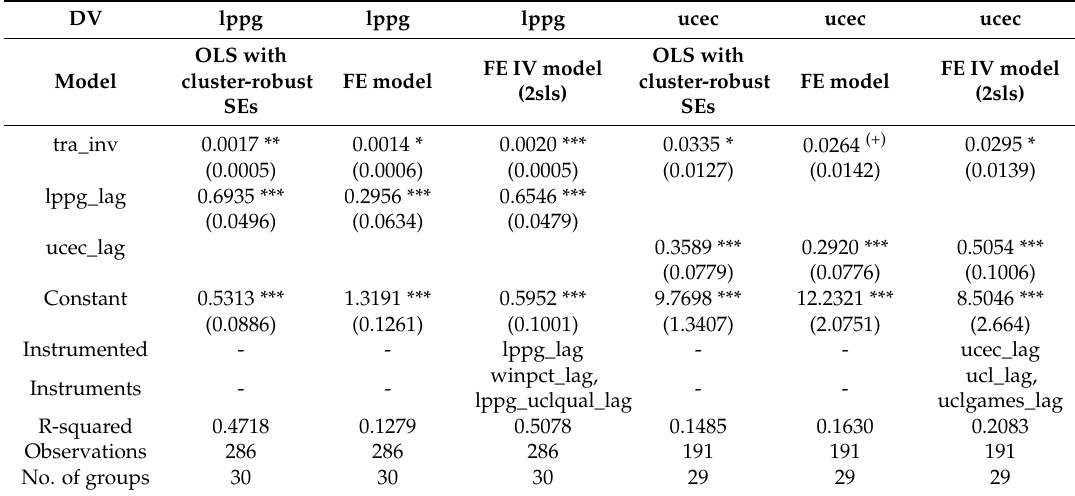
Table 9. Key regression results: sporting